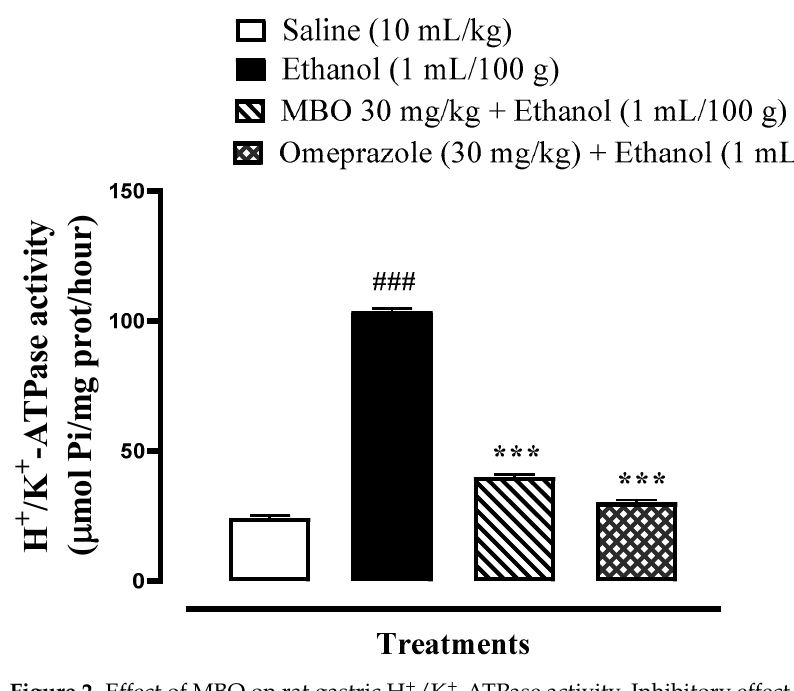
Figure 2. Effect of MBO on rat gastric H + /K + -ATPase activity. Inhibitory effect was analyzed using the colorimetric method. Values expressed as mean ± SEM ( n = 3). Significance at *** p < 0.001, ### p < 0.001.